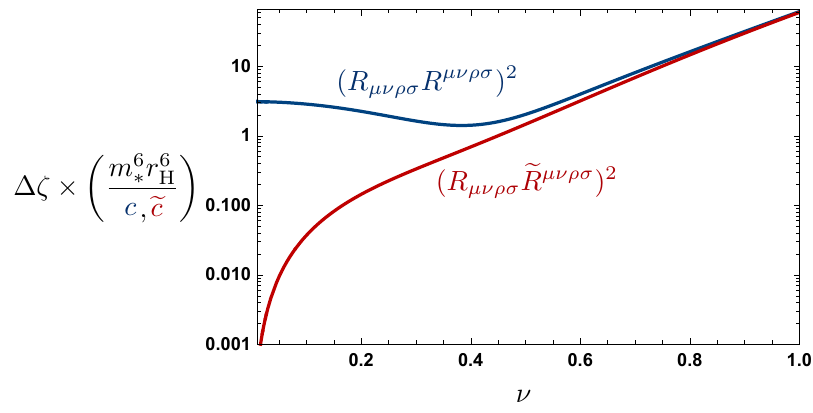
Figure 4 . Shift in KN extremality parameter ζ induced by the quartic Riemann